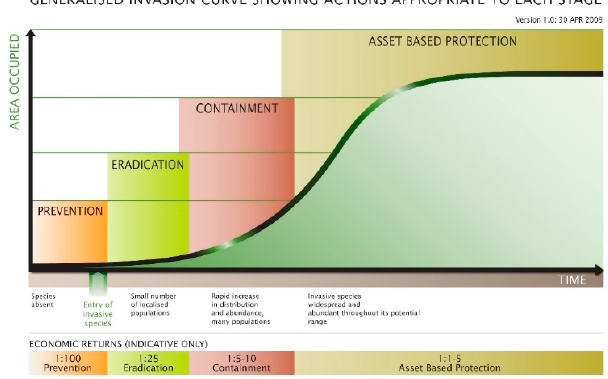
Figure 1. Estimated return on government investment for four weed biosecurity approaches (prevention, eradication, containment and asset-based protection) undertaken at increasing time since weed invasion and area occupied by the weed [26] .